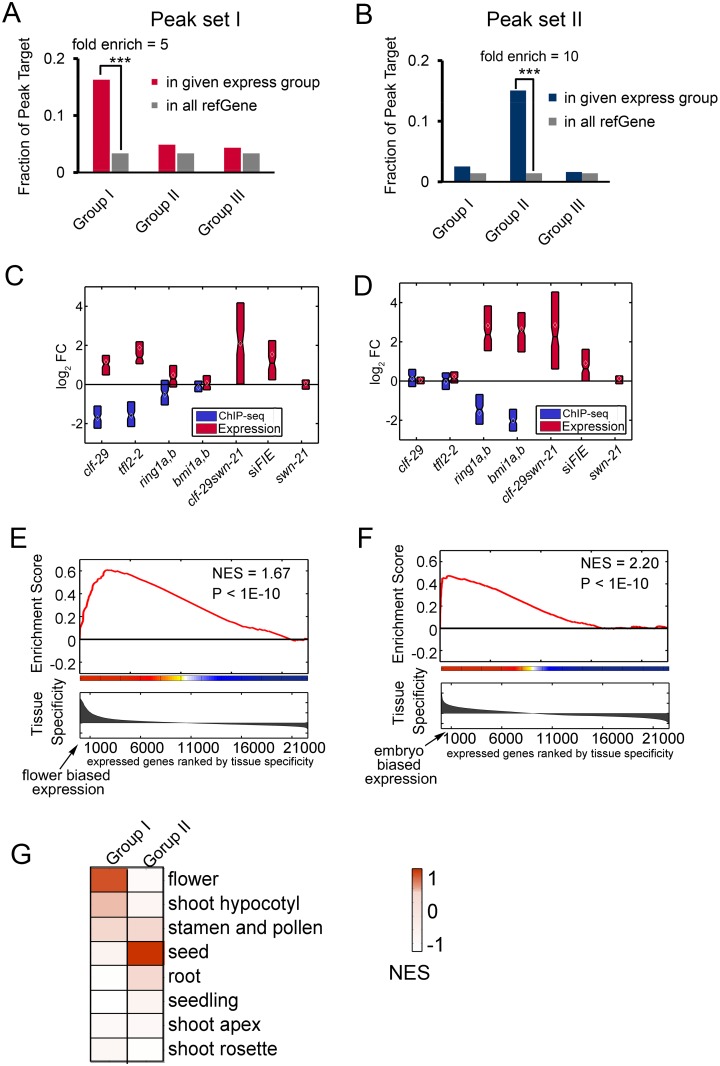
Targets of different combinations of PcGs and their expression bias.(A) Enrichment analysis of peak set I targets in three expression groups shown in Fig 4A. ***, Fishers’ exact test P value < 1e-3. (B) Enrichment analysis of peak set II targets in three expression groups shown in Fig 4A. ***, Fishers’ exact test P value < 1e-3. (C-D) Box plot showing the distribution of expression changes and H3K27me3 changes for 108 genes (C) and 164 genes (D) in PcG mutants. (E-F) Gene Set Enrichment Analysis (GSEA) showing a significant normalized enrichment score (NES) for flower biased expression of 108 genes (E) and embryo biased expression of 164 genes (F). The x axis represents all expressed genes ranked by tissue specificity as determined by expression profile, y axis presents the running enrichment score. (G) Heatmap showing NES calculated by GSEA for 108 genes and 164 genes in different gene sets with distinct tissue biased expressions.